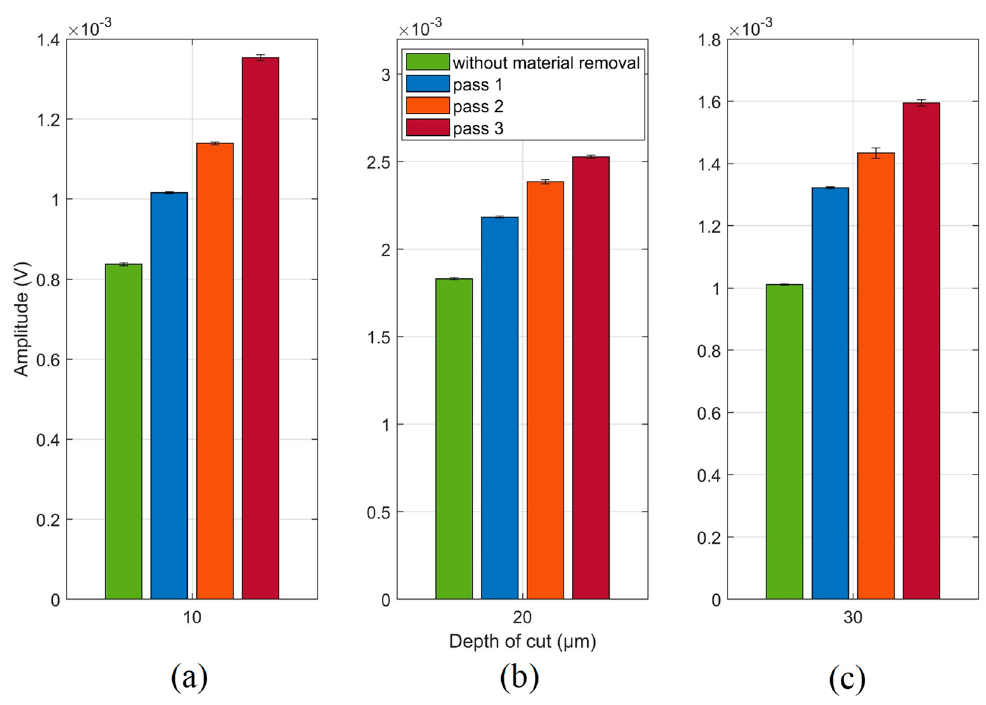
Figure 11. RMS mean and standard deviation values of the raw filtered signals at ( a ) 10 µm; ( b ) 20 µm and ( c ) 30 µm.